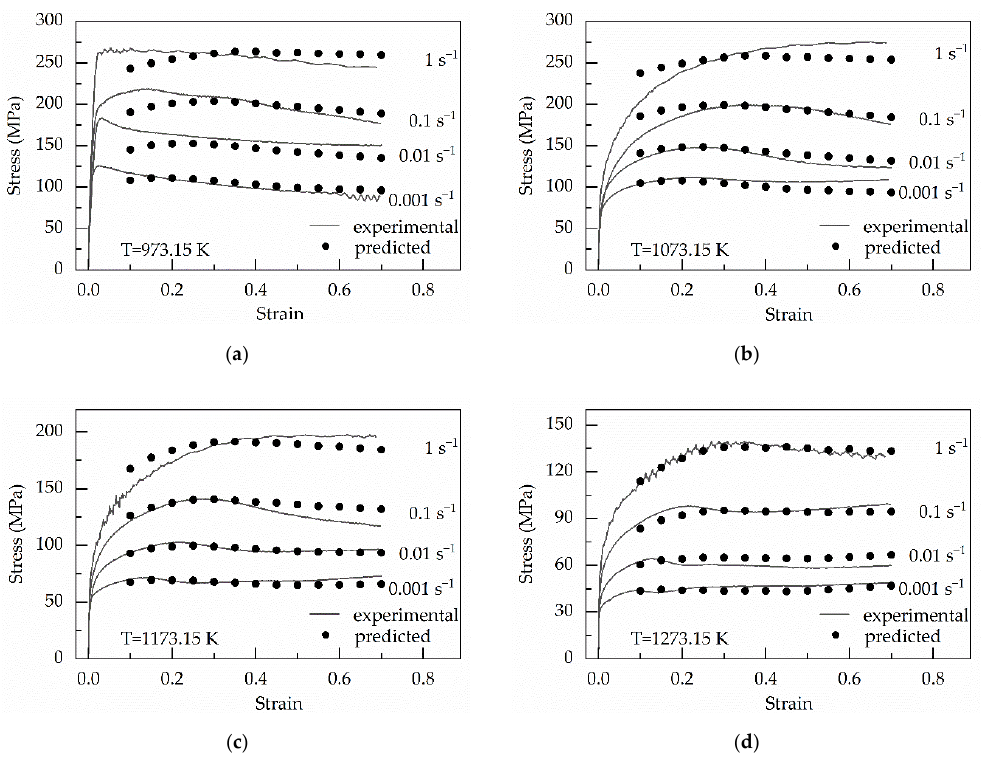
Figure 15. Comparison between the experimental and predicted stress by in the msA-type equation at temperatures of ( a ) 973.15 K; ( b ) 1073.15 K; ( c ) 1173.15 K; ( d ) 1273.15 K.